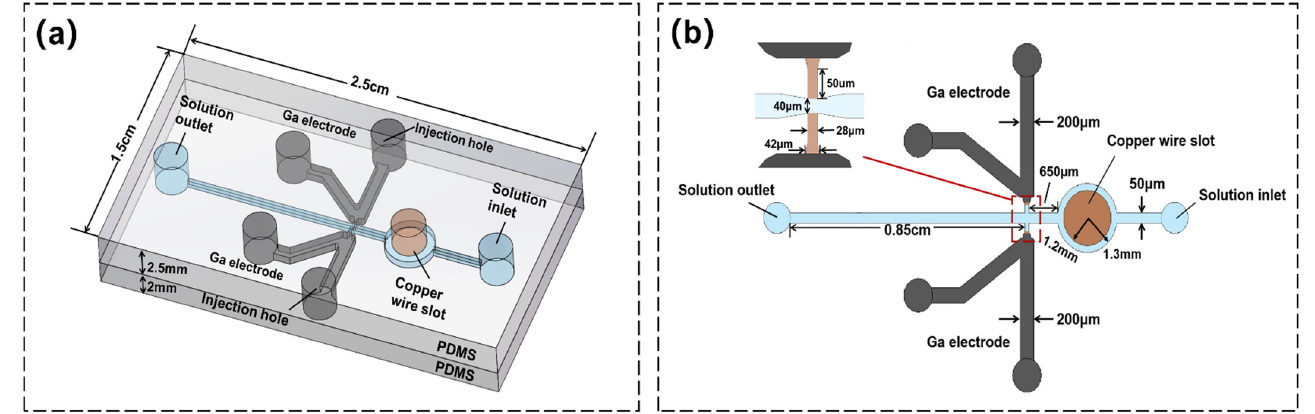
Figure 1. Chip structure diagram: ( a ) 3D structure diagram of the chip. ( b ) Plane diagrammatic sketch of the chip. The transverse electroplating solution microchannel is 50 μ m wide. The electrode microchannel is 200 μ m wide. The diameter of the circular microchannel is 1.3 mm, and the diameter of copper wire is 1.2 mm. The vertical distance from the circular channel to the electrode is 650 μ m. For the microstructure part, the upper bottom of the trapezoidal gap is 42 μ m. The lower bottom is 28 μ m. The rectangular area is 28 μ m wide and 50 μ m long. The microchannel width between the electrode areas is 40 μ m.